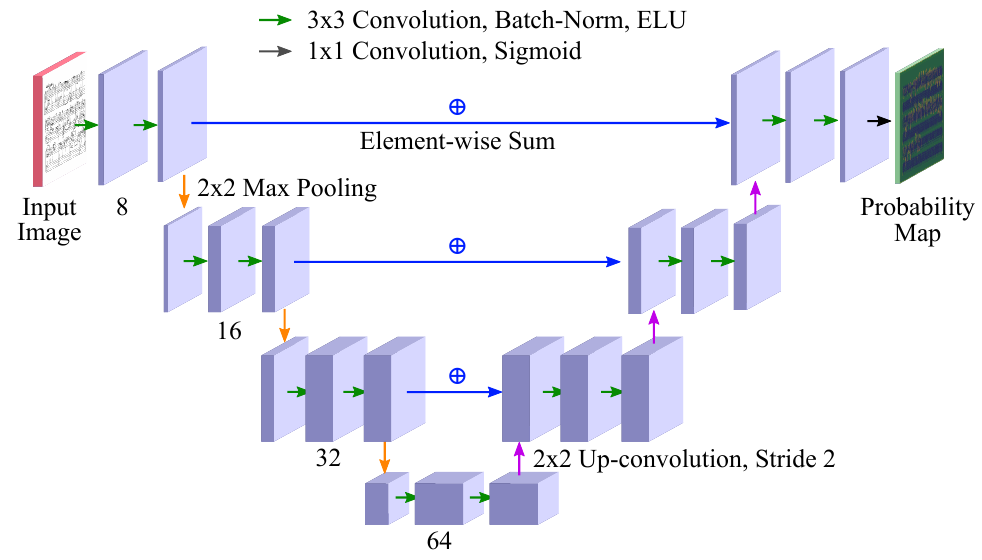
Figure 2. The U-Net architecture, with computation flowing left-to-right; the “hourglass” is unrolled downwards. Green arrows indicate 2D convolution with 3 × 3 kernels, downward orange arrows indicate 2 × 2 Max-Pooling, upward purple arrows indicate 2 × 2 up-convolution, and blue arrows indicate element-wise sums that form the residual connections between corresponding parts of the two “hourglass”